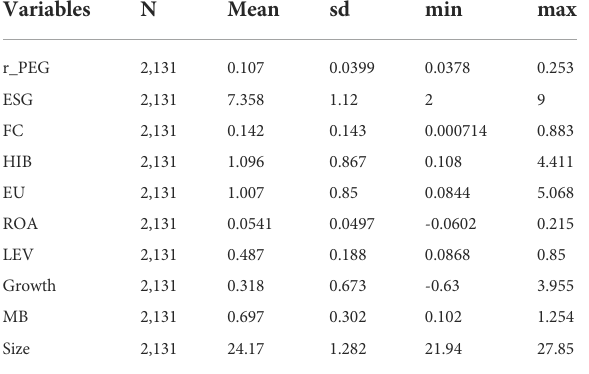
TABLE 2 Descriptive statistics. TABLE 3 Results of benchmark and moderation